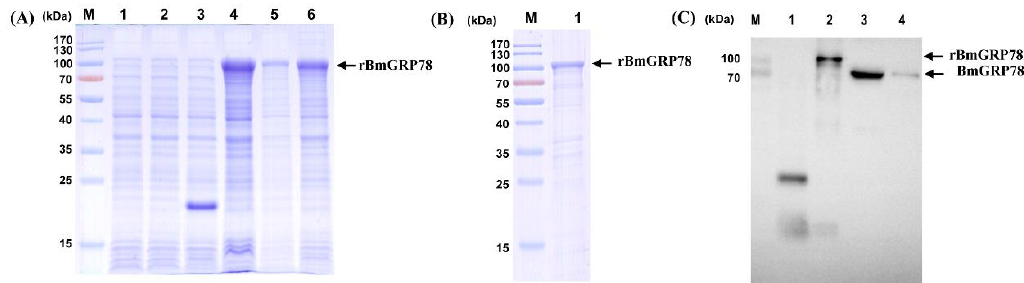
Figure 3. Identification of purified rBmGRP78 protein and specificity of rabbit polyclonal antibody against recombinant and endogenous BmGRP78 protein, respectively. ( A ) SDS-PAGE analysis for rBmGRP78 expression in E. coli BL21 (DE3) induced by IPTG. Lane M: Pre-stained Protein Marker; Lane 1: pET-32a(+) in BL21, no IPTG treatment; Lane 2: pET-32a(+)- rBmGRP78 in BL21, no IPTG treatment; Lane 3: pET-32a(+) in BL21, IPTG treatment; Lane 4: pET-32a(+)- rBmGRP78 in BL21, IPTG treatment; Lane 5: Supernatant of pET-32a(+)- rBmGRP78 in BL21 after ultrasonication; Lane 6: Precipitation of pET-32a(+)- rBmGRP78 in BL21 after ultrasonication. The arrow indicated the band of expected molecular weight for rBmGRP78 protein. ( B ) SDS-PAGE analysis of rBmGRP78 purification in E. coli BL21 (DE3) induced by IPTG. Lane M: Pre-stained Protein Marker; Lane 1, purified rBmGRP78 protein after ultrafiltration. ( C ) Identification of the specificity of anti-rBmGRP78 antibody using Western blotting. Lane M: Pre-stained Protein Marker; Lane 1, pET-32a(+) in E. coli BL21, no IPTG treatment; Lane 2, Supernatant of pET-32a(+)- rBmGRP78 in BL21, IPTG treatment; Lane 3, Total proteins of BmN cells; Lane 4, Total proteins of epidermis tissue. The arrow represents recombinant and endogenous BmGRP78 protein.